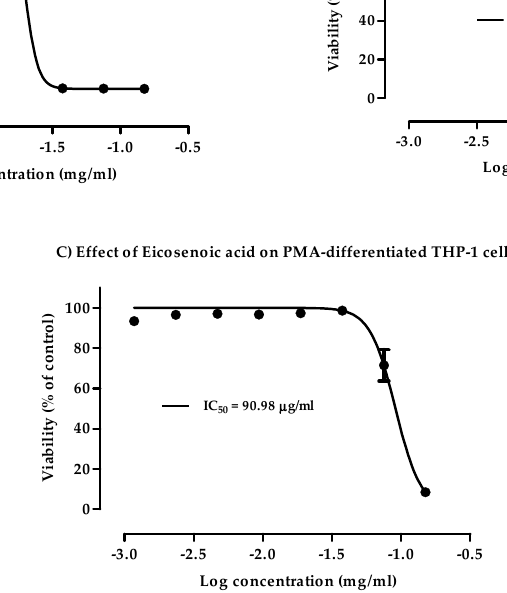
Figure 2. Cytotoxic effects of eicosenoid compounds at varying doses on phorbol 12-myristate 13-acetate (PMA)-differentiated THP-1 cells. ( A ) (Z)-11-eicosenol (11E-OH) compound was cytotoxic to PMA-treated cells. ( B ) Eicosenoate (11E-ester) compound was non-cytotoxic to PMA-treated cells. ( C ) Eicosenoic acid (11E-acid) compound was cytotoxic to PMA-treated cells. Each data point represents the mean ± SD ( n = 3).